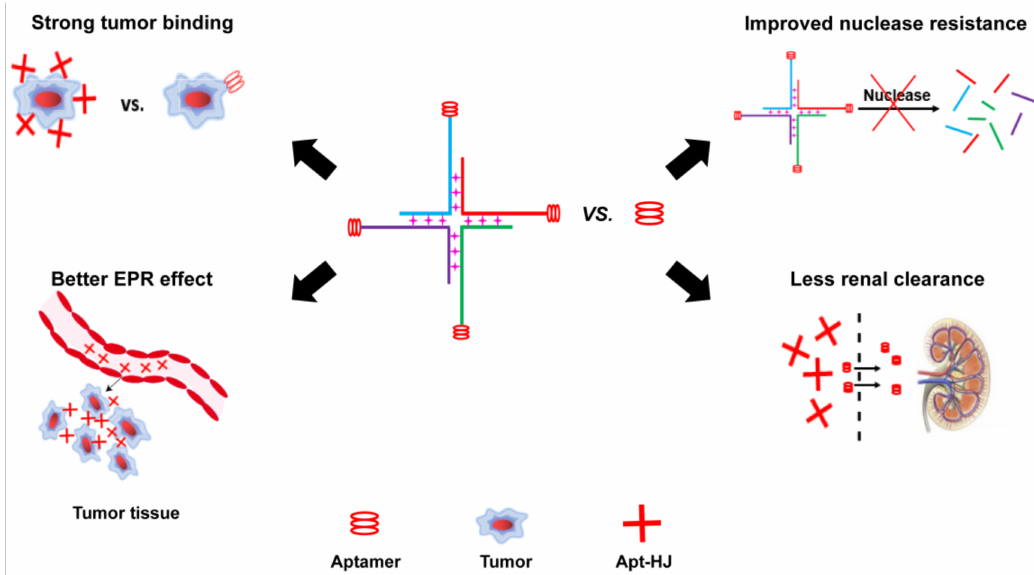
Figure 9. Schematic illustration of the possible working mechanisms of Apt-HJ. Compared with free Apt, Apt-HJ has stronger binding with tumor cells, better enhanced permeability and retention (EPR) effect, improved nuclease resistance, and less renal